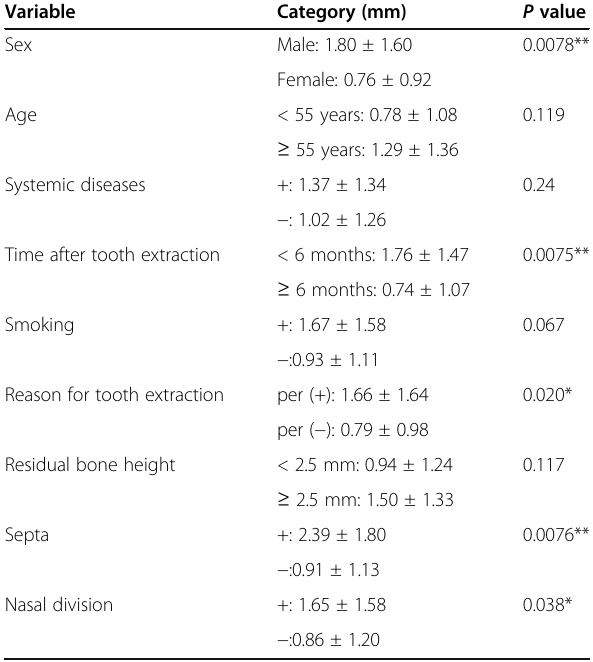
Table 2 Factors influencing sinus mucosal